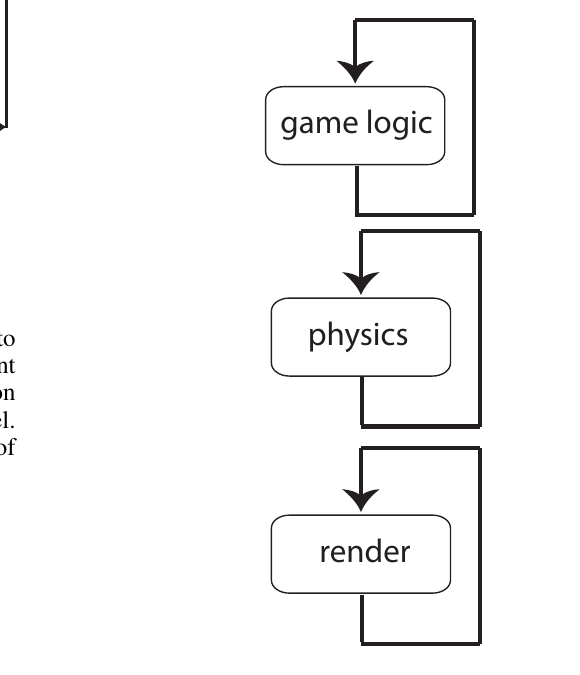
Figure 6. Asynchronous Function Parallel